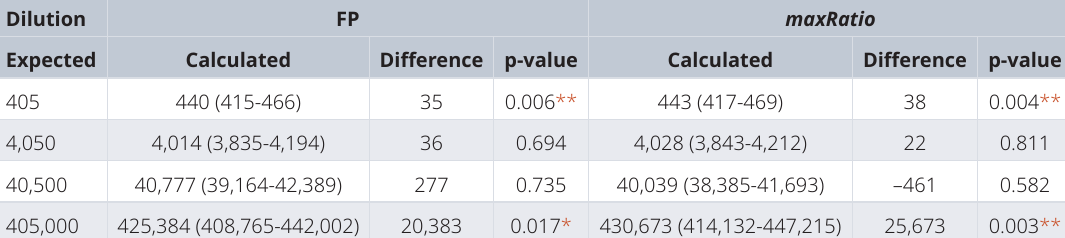
Table 1. Comparison of copy numbers for the control dilutions. The mean VL is reported together with the 95% CI (calculated), the difference between the calculated and the expected concentration (difference), and the result of the t-test (p-value). Statistical significance is represented by * and ** for values below 0.05 and 0.01, respectively. The copy numbers are given in